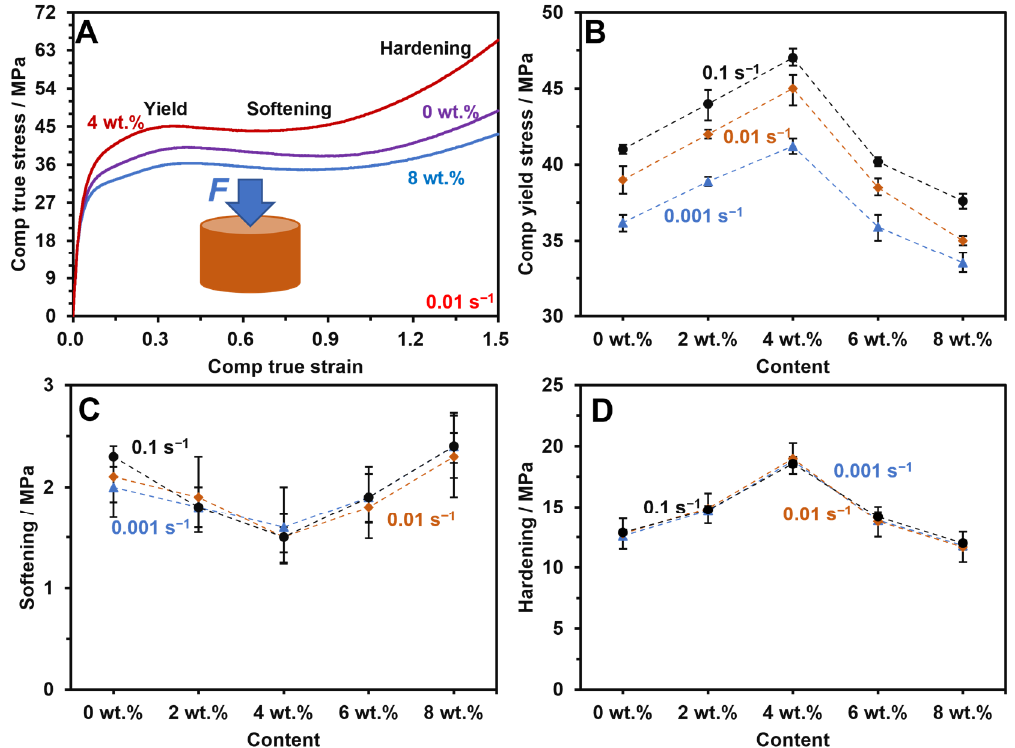
Figure 3. True strain-stress from the compression test of the HDPE composite: ( A ) complete strain- stress curve; ( B ) true yield stress, ( C ) strain-softening, and ( D ) strain-hardening, under different Si 3 N 4 contents and strain rates.